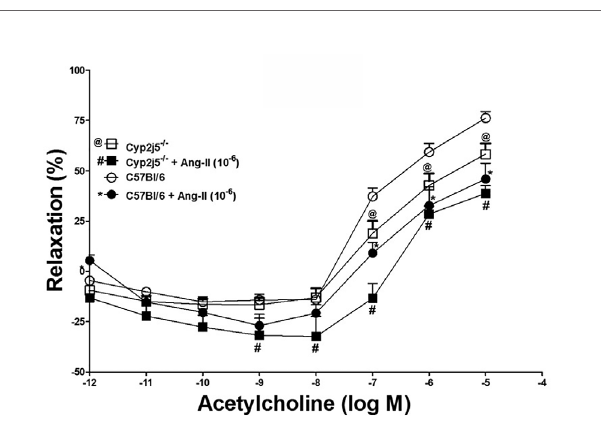
FIGURE 1 | Acetylcholine (ACh)-induced concentration dependent vascular response in aortic rings of C57Bl/6 and Cyp2j5 − / − mice. * P < 0.05 between C57Bl/6 vs . Cyp2j5 − / − mice, there is a signi fi cant difference found in (ACh)- induced concentration (10 − 7 M – 10 − 5 M) dependent vascular response between C57Bl/6 and Cyp2j5 − / − mice (* P < 0.05).Values expressed as means± SE. n =